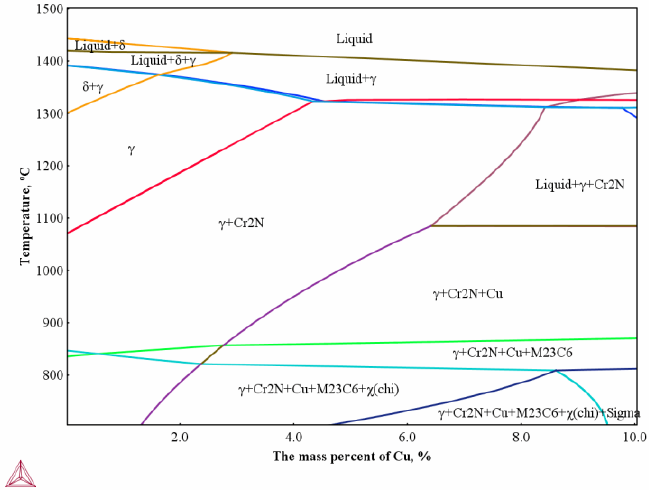
Figure 2. Equilibrium phase diagram of tested alloy calculated by Figure 2 . Equilibrium phase diagram of tested alloy calculated by Thermo-calc.